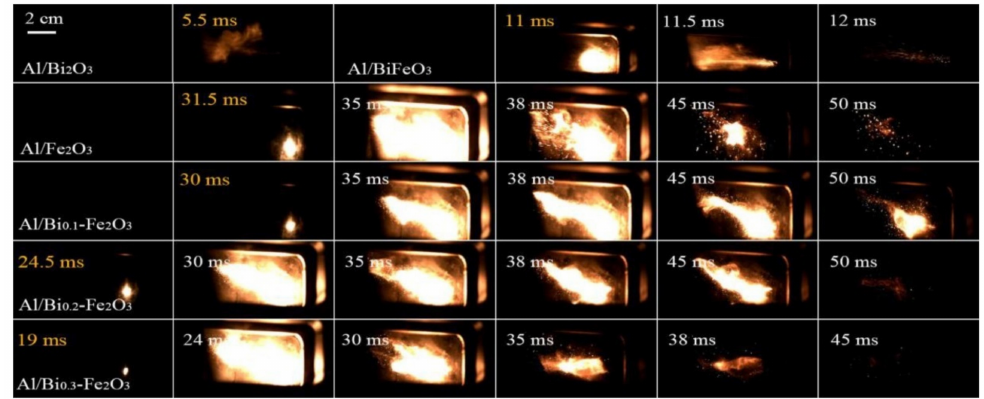
Figure 28. Sequential images of Al/Fe 2 O 3 , Al/Bi doped Fe 2 O 3 , Al/Bi 2 O 3 and Al/BiFeO 3 combustion process in ambient condition. Reproduced with the permission of ref. [134]. Copyright 2021, Chemical Engineering